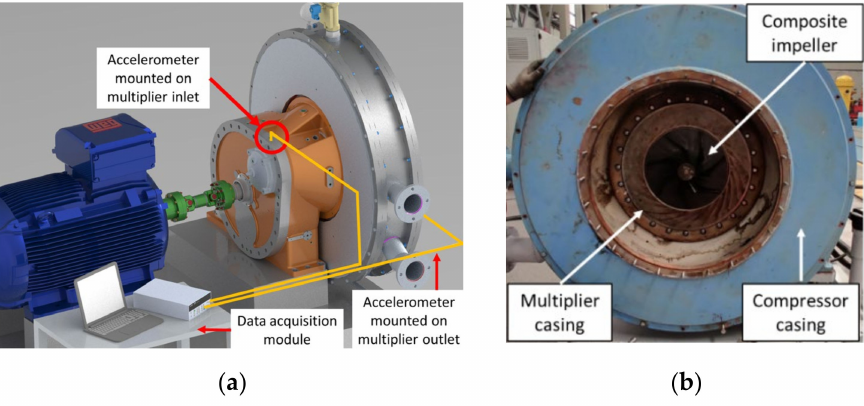
Figure 20. Composite impeller test set-up: ( a ) schematic representation of accelerometer positioning; ( b ) impeller position in the compressor